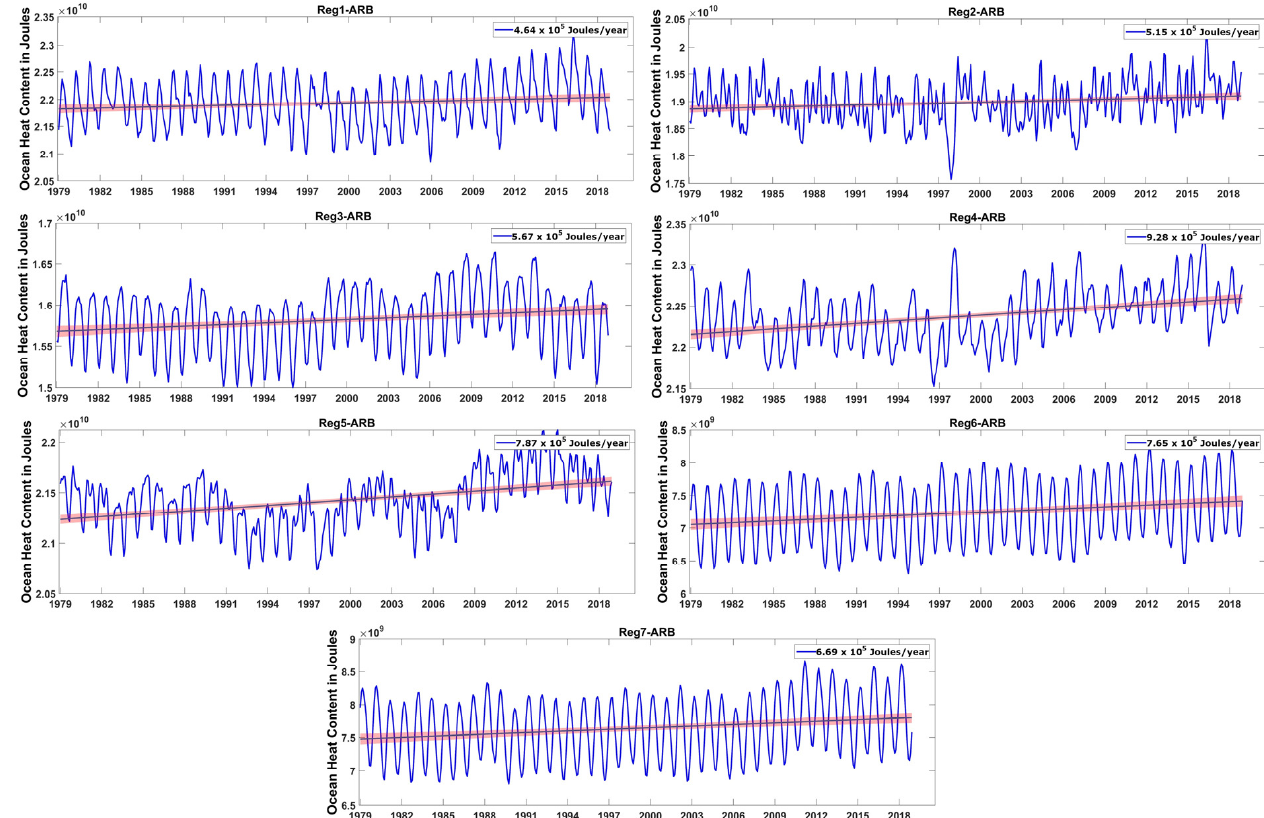
Figure 2. Variability in ORAS5 OHC at 300 m along with the corresponding confidence interval (red patches) at different sub-domains of the Indian Ocean region (1979–2020).